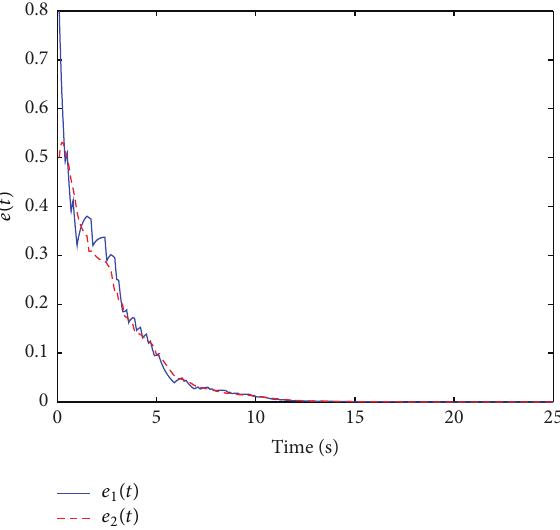
Figure 4: The response of error 𝑒(𝑡) with partially unknown Π . Figure 5: The response of error 𝑒(𝑡) with uncertain Π .